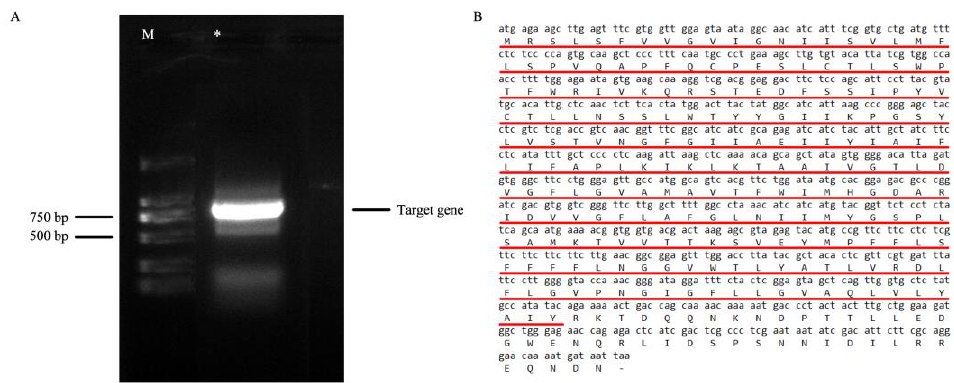
Figure 6. PCR amplification ( A ) and the coding sequence ( B ) of PgSWEET17a. Note: DL ladder 2000 DNA Marker; *: Pomegranate cDNA template; the red line is the MtN3/saliva domain.